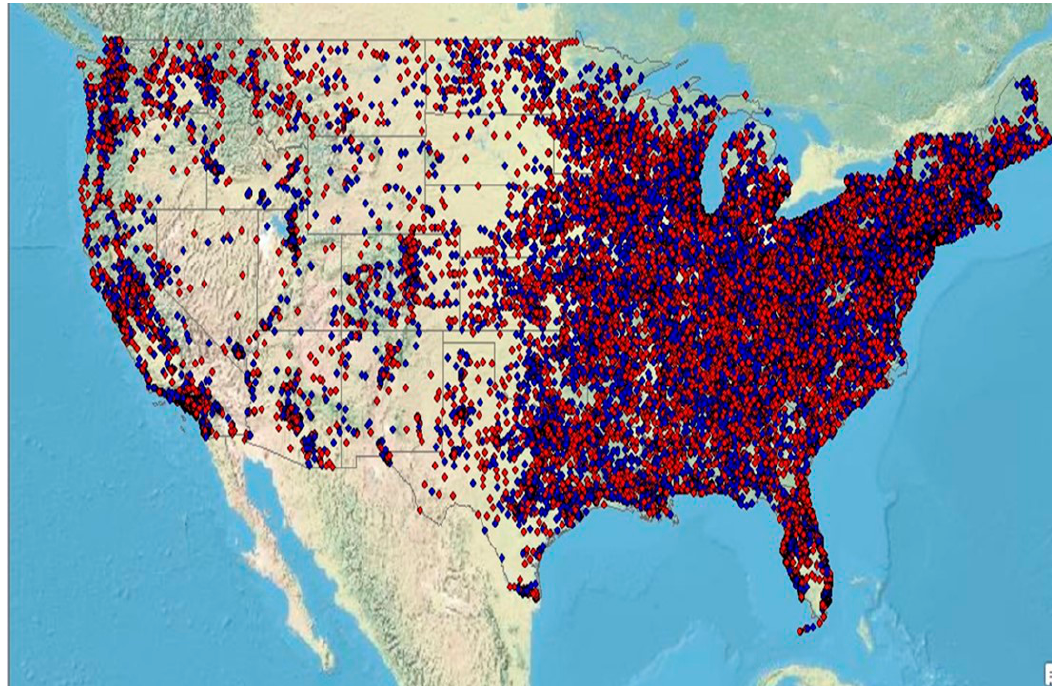
Figure 1. Geo-linked representation of individual patients who are adherent (blue symbols) or nonadherent to their positive airway pressure (PAP) therapy device. The data for 170,641 individuals (63.7%) of our available database with valid ZIP codes are shown. Note that more than half the symbols are red denoting a greater proportion of nonadherent individuals in this database.